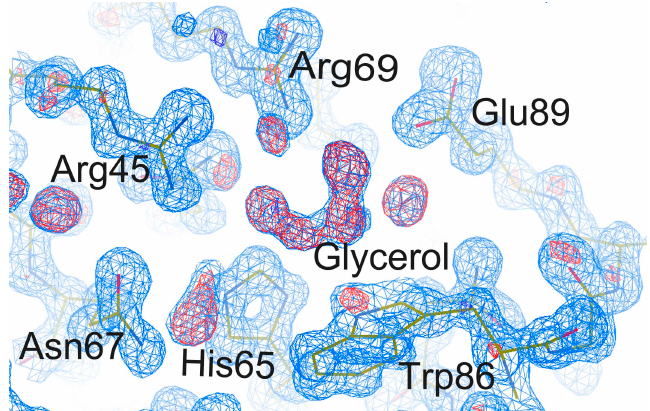
Figure 4. Electron density map of the carbohydrate binding site binds to glycerol in structure 1 (PDB code : 5GZC) of Gal-8_1-186. The 2| F o | − | F c |, α c map contoured at 1 δ is shown as blue density and the | F o | − | F c |, α c map contoured at 3 δ is shown as red density.